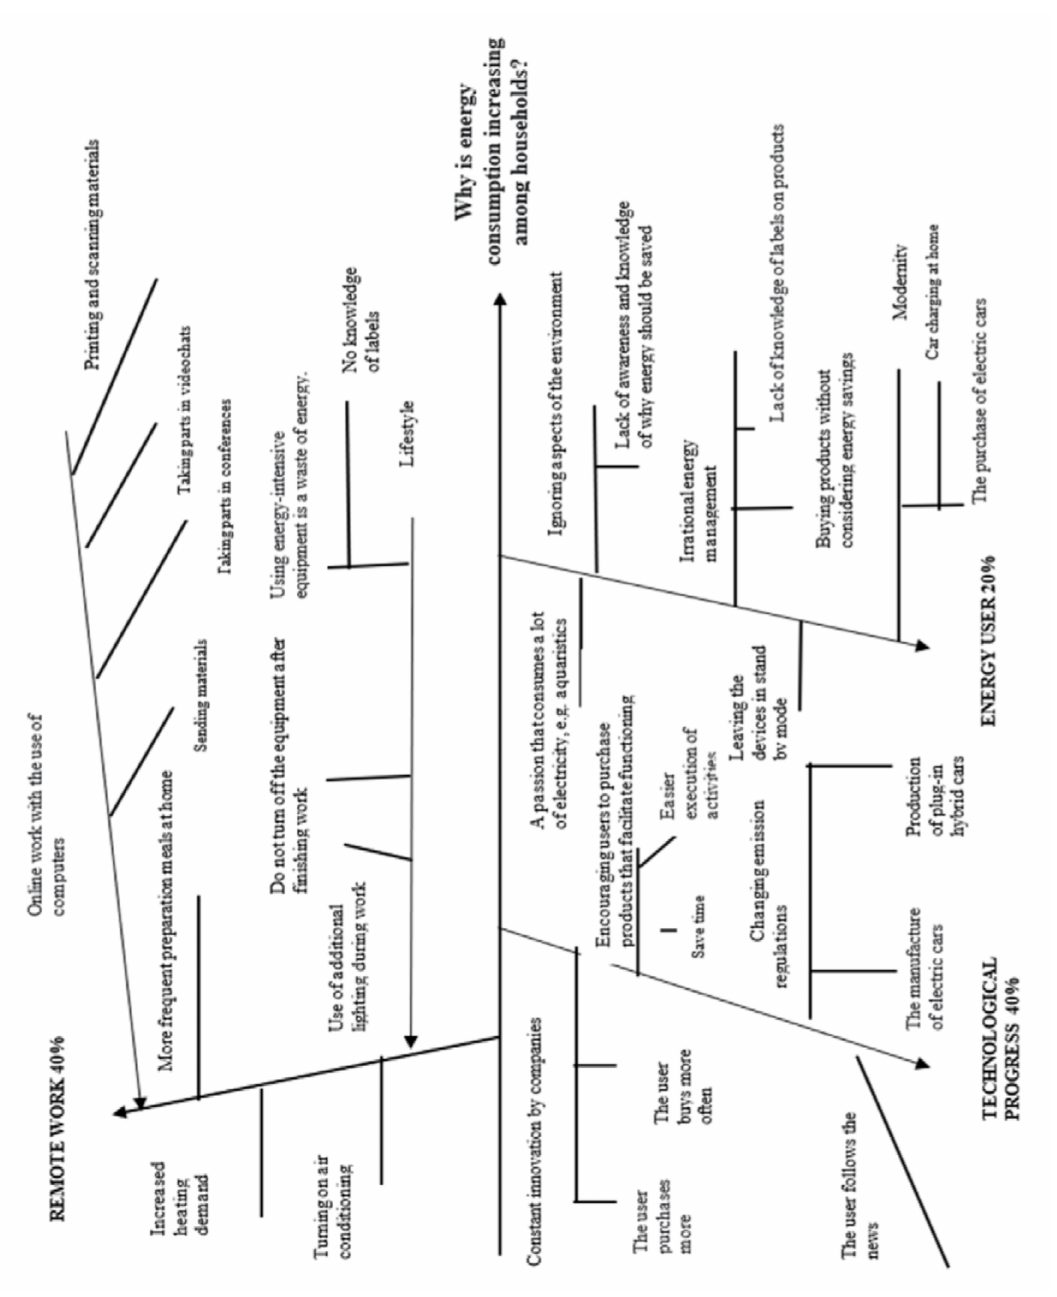
Figure 2. Ishikawa diagram base on the question: Why is energy consumption increasing among households? Table 1. Kind of lighting using in respondents’ home. Kind of